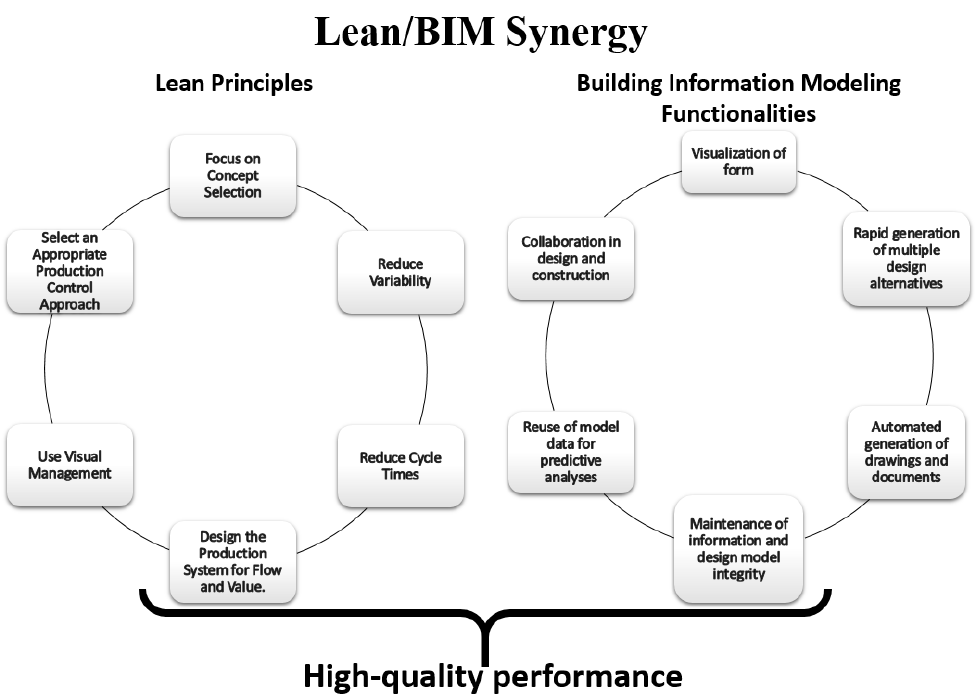
Figure 3. Lean principles and BIM functionalities synergy. Table 2. Lean/BIM interactions during the design phase. Lean/BIM Synergy in the Design Phase